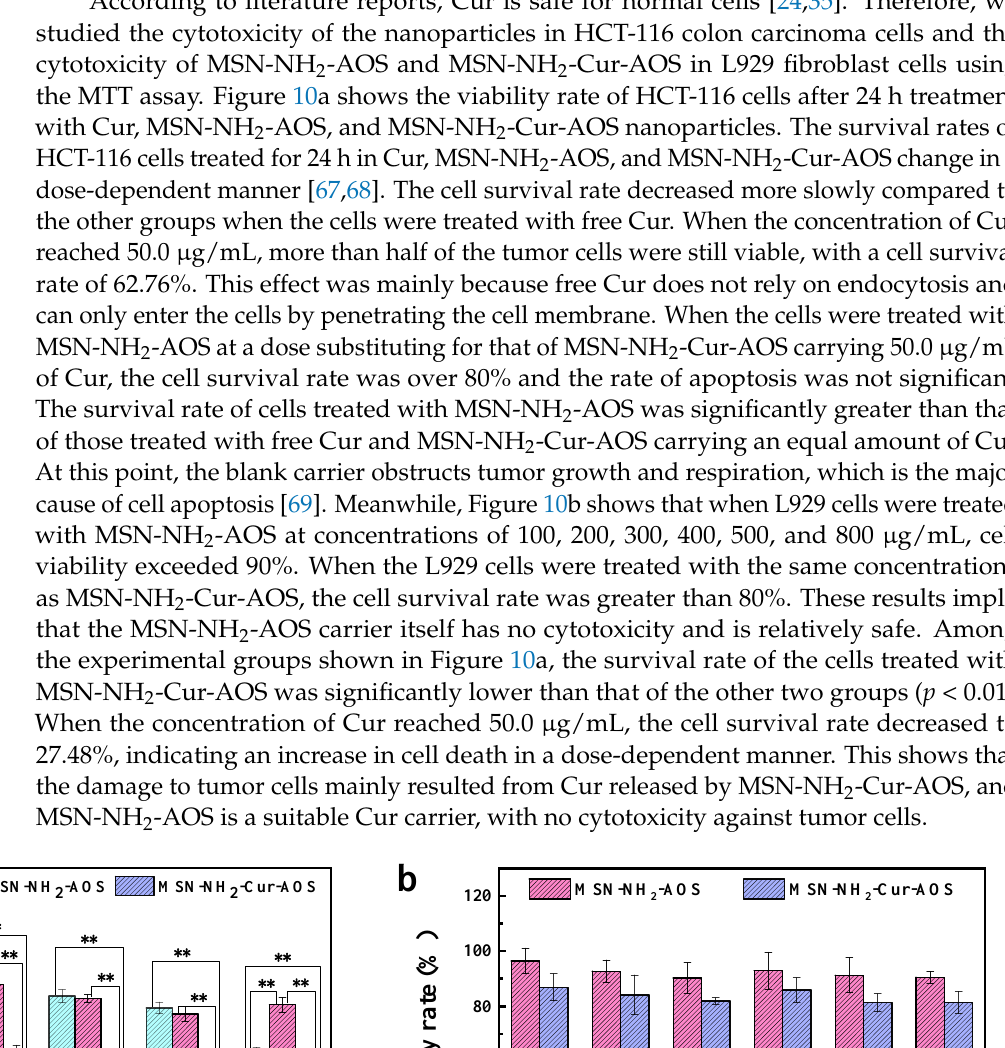
Figure 11. Fluorescence images of cells treated with MSN-NH 2 -Coumarin-6-AOS for 30 min ( a ) and 1 h ( b ). 4. Conclusions MSN has the advantages of adjustable pore size and controllable particle size and provides a rich loading space for drugs. Moreover, the presence of large amounts of silicon hydroxyl on the surface provides functionalization sites. In this study, AOS was incorpo- rated into MSN using a silane coupling agent as an intermediate to render the composite nanoparticles pH-responsive, biocompatible and stable. The best AOS:MSN ratio was 1:1, and the average particle size was about 236.8 nm, with a surface potential of − 33.1 mV. Below 800 °C, the loss of water adsorbed on the surface of the nanoparticles was only 1.5%, which enables a wide range of applications for drug storage and transportation. The